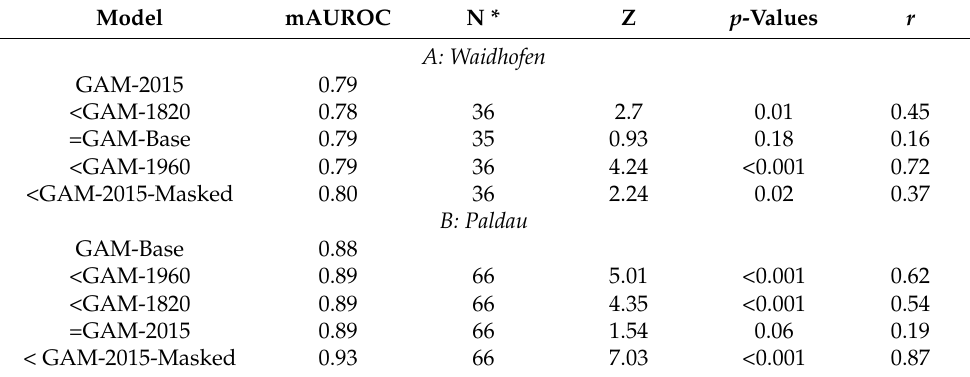
Table A5. Wilcoxon signed-rank tests for AUROC performance differences within each study area estimated with